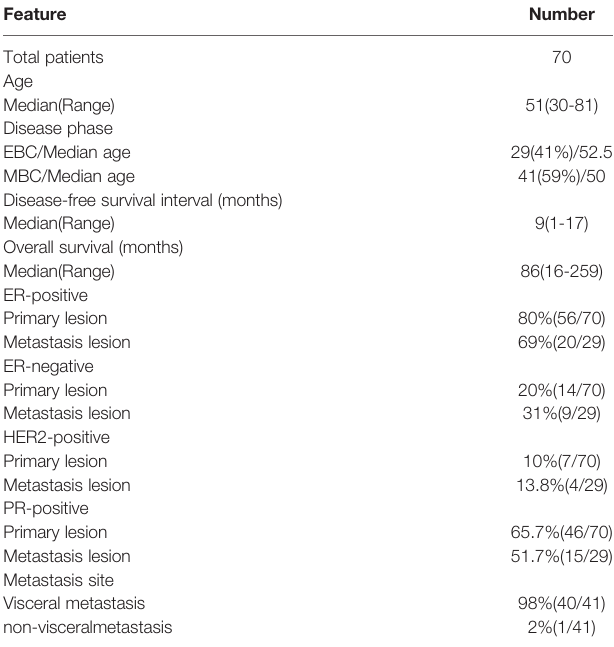
TABLE 1 | Patient